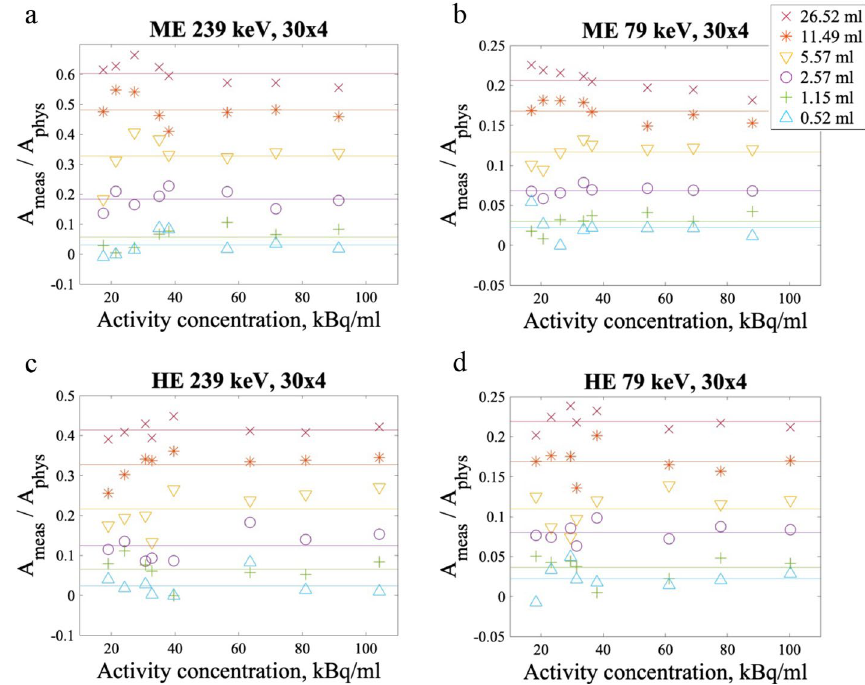
Fig. 4 Activity in each sphere measured from the mean counts in the images divided by the known, physical activity in each sphere plotted against activity concentration. The figure shows the results obtained with the filtered 30 4 reconstruction, with ME 239 keV in panel a , ME 79 keV in panel b , HE 239 keV in panel c , and × HE 79 keV in panel d . Equivalent figures for the other reconstructions with and without filters applied can be found in the supplementary material. The mean activity ratio for the sphere volume is shown as a line. Of note, the x‑axes are the same, but the values on the y‑axes